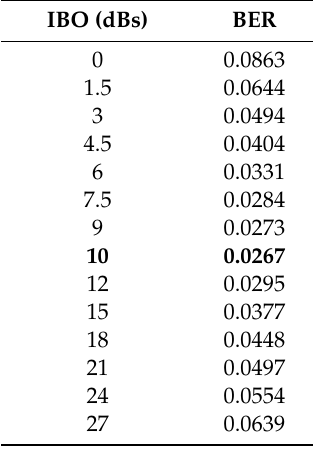
Table 3. Simulated IBO